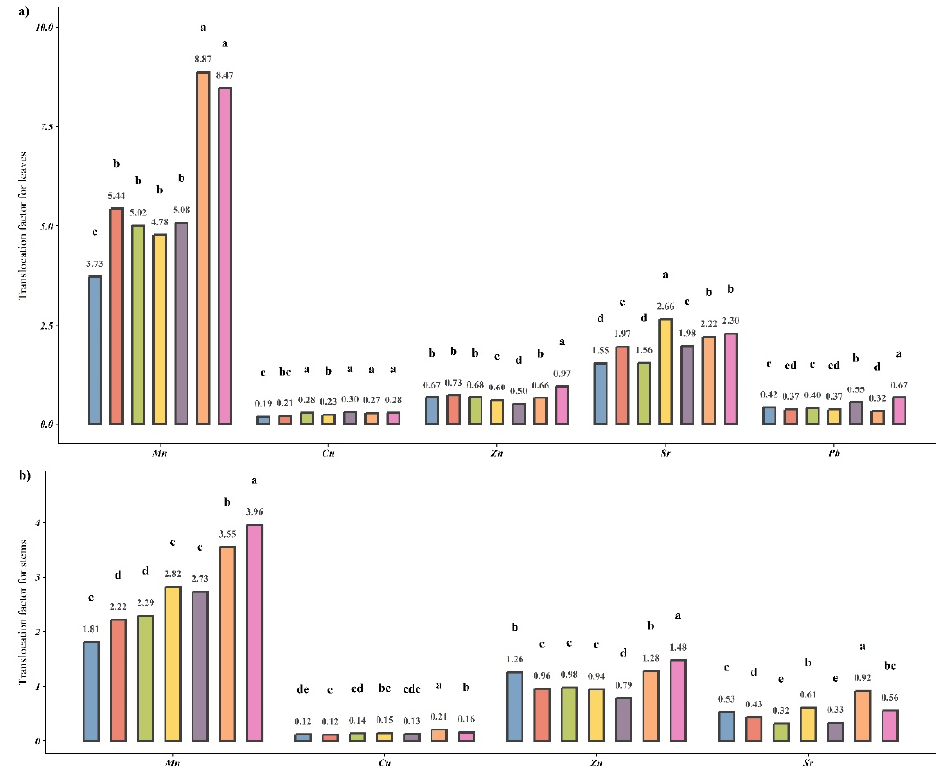
Figure 3. TLFs of TEs accumulated in the AGB of M. × giganteus during growth in TEs-contaminated soil in the presence of PGPB strains for ( a ) leaves and ( b ) stems. Different letters within one TE indicate a significant difference between treatments.